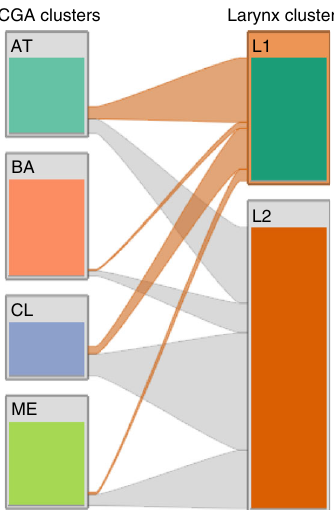
Fig. 6 Relationship between SCCHN TCGA (mRNA derived) subtypes, and integrative clustering-derived laryngeal subtypes assigned in this study. The left column represents the distribution of laryngeal tumors among the 256 SCCHN specimens (laryngeal, oral, oropharynx, and hypopharynx) assigned by the TCGA as atypical (AT), basal (BA), classical (CL), and mesenchymal (ME) subtypes. Gray and orange bands indicate the redistribution of TCGA laryngeal tumors to the L1 and L2 prognostic clusters de fi ned in this work (right). The plot shows that the majority of tumor samples in L1 cluster belong to the atypical (52%) and classical (33%) subtypes, whereas the majority of L2 tumor samples belong